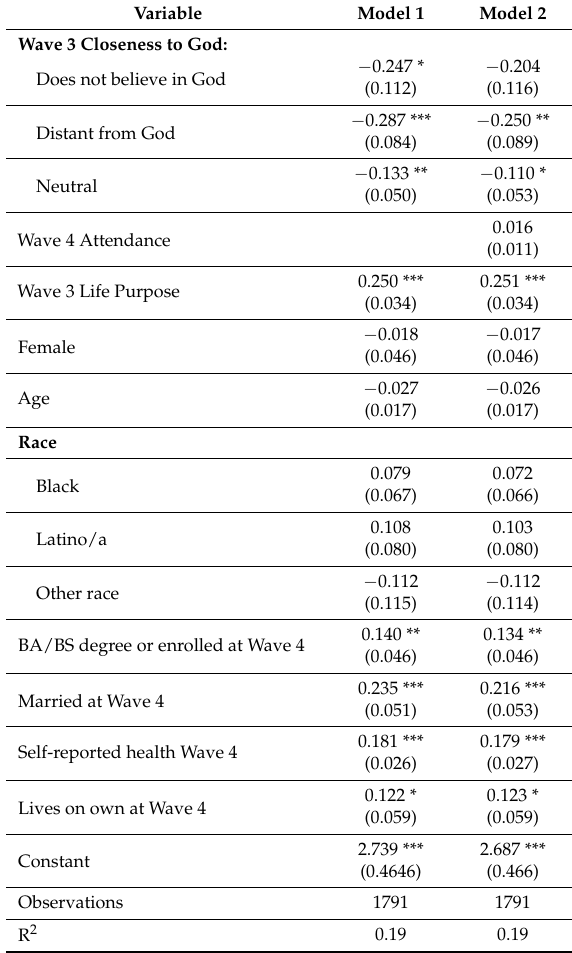
Table 3. Wave 4 Life Purpose Regressed on Wave 3 Closeness to God and Controls (Lagged Dependent Variable